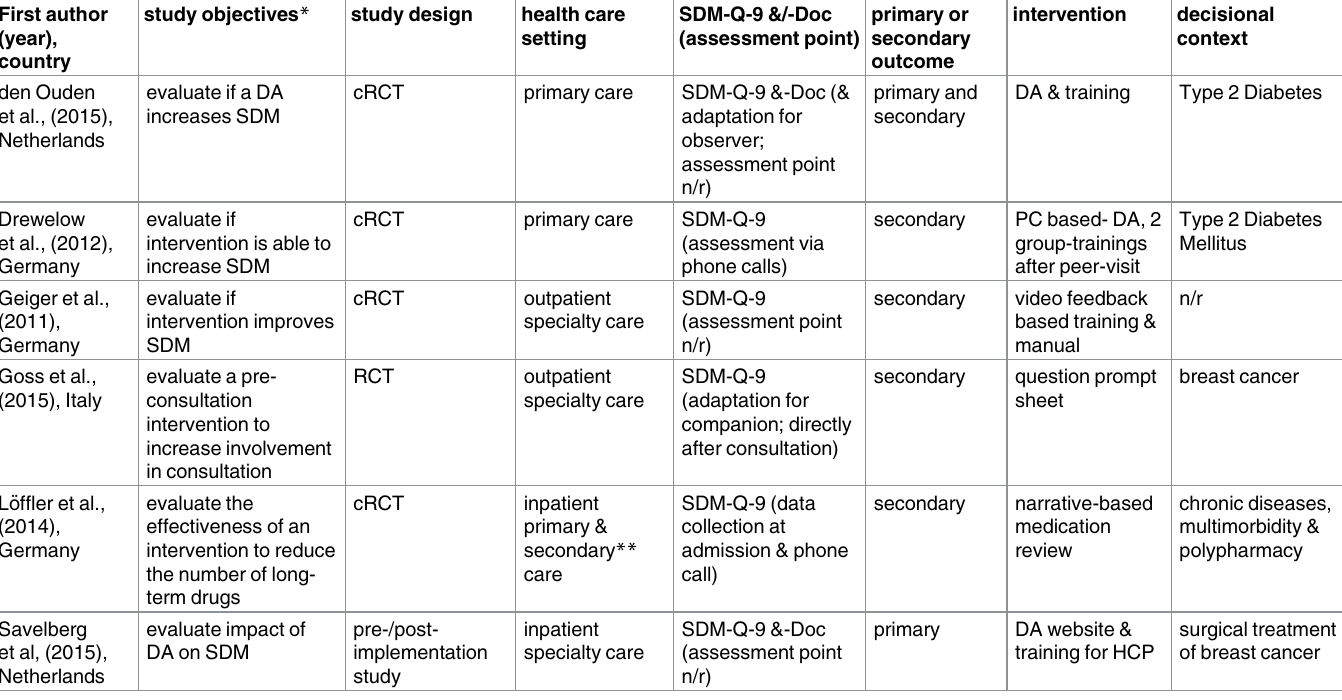
Table 4. Characteristics of the included study protocols.